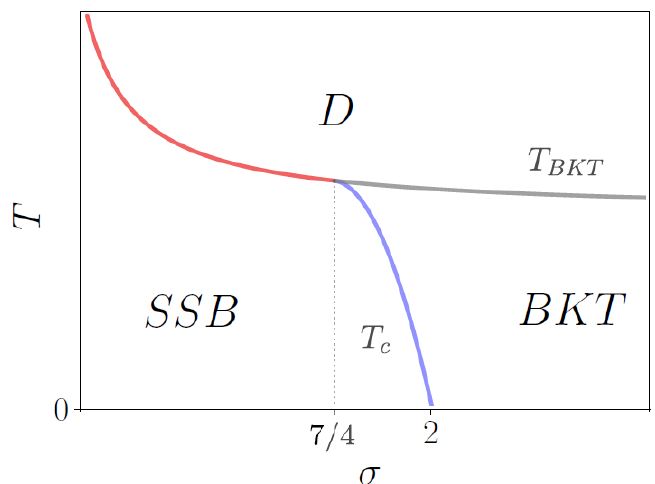
Figure 3 . Qualitative phase diagram of the long-range XY model as predicted in ref. [1], which differs from the one obtained for the Villain model in figure 2. In particular, the critical value σ ∗ of σ at which the long-range behavior takes over depends on T and varies from 7 / 4 and 2